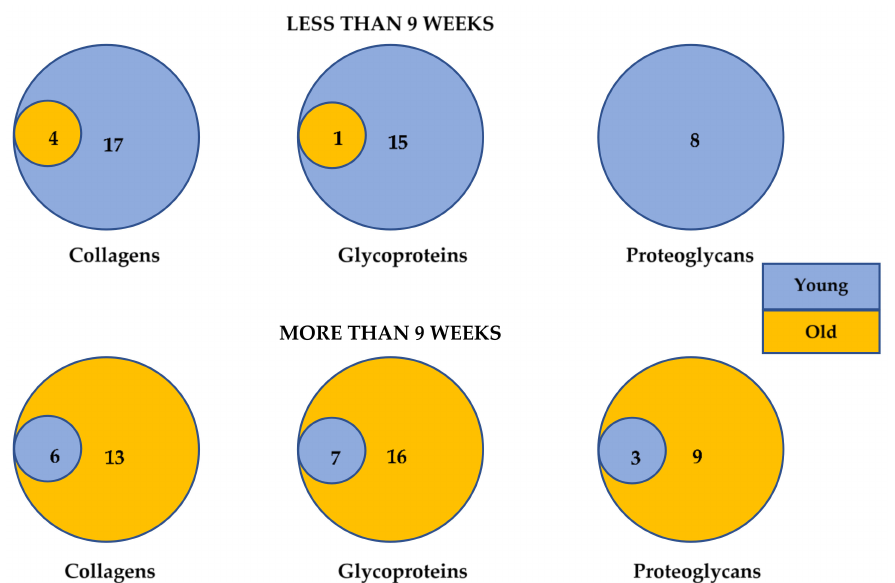
Figure 2. Venn diagrams of the upregulated collagens, proteoglycans and glycoproteins ECMs transcriptomes in healthy young and old participants when exercise training lasted less than or more than 9